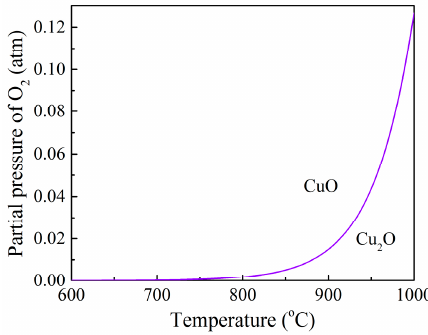
Figure 3. Equilibrium partial pressure of oxygen over the CuO/Cu 2 O redox pair.